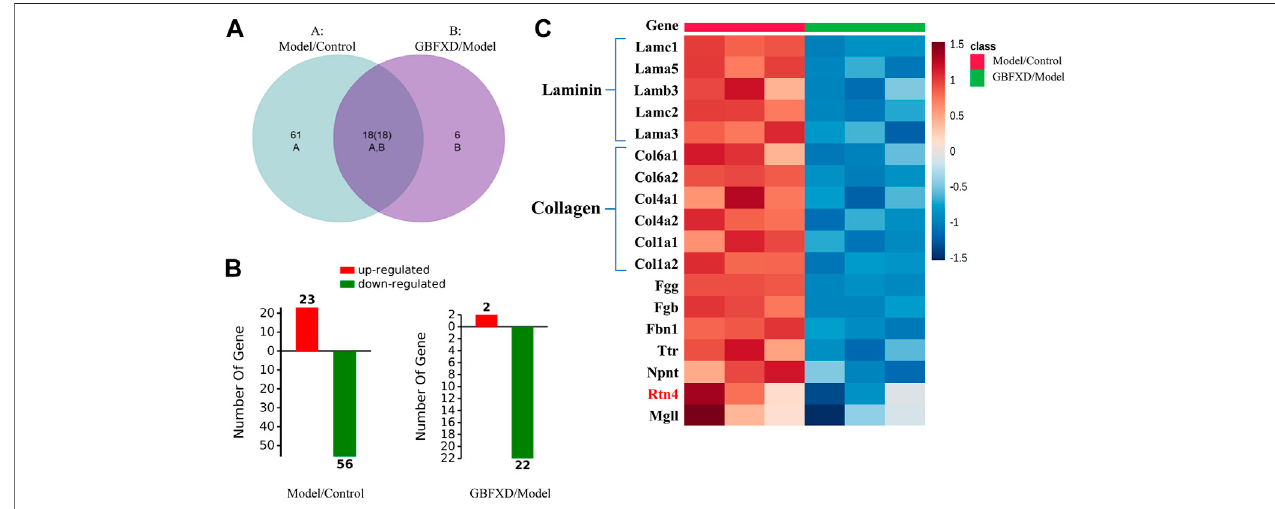
FIGURE 4 | The differentially expressed proteins (DEPs) in lung between Model/Control and GBFXD/Model. (A) Venn-diagram of DAPs. (B) The left was DAPs involved in Model/Control and the right was GBFXD/Model (the numbers of upregulated, downregulated proteins characterized by Red and Green, respectively). (C) Heat map of overlap